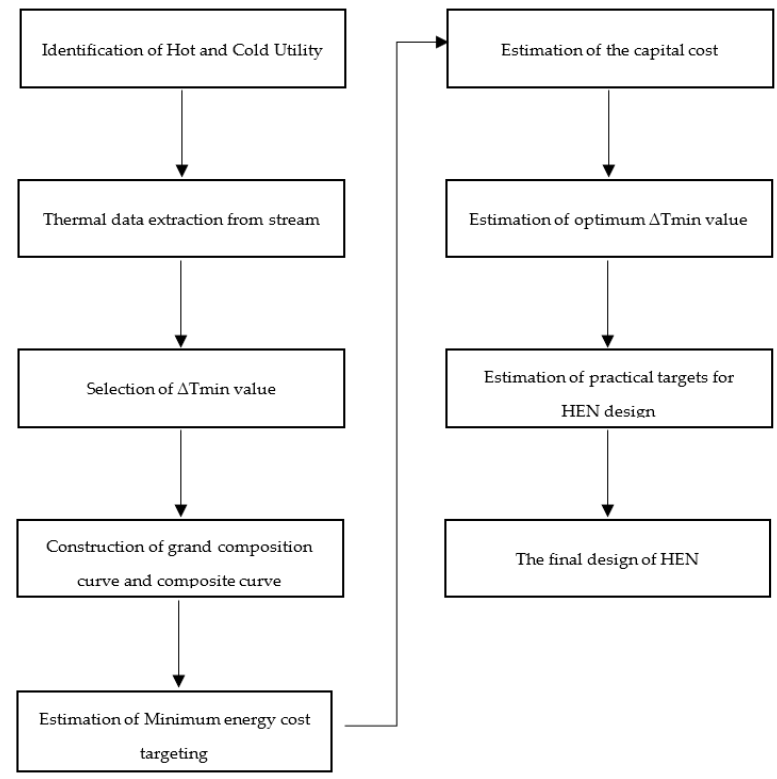
Figure 6. Steps of pinch analysis.